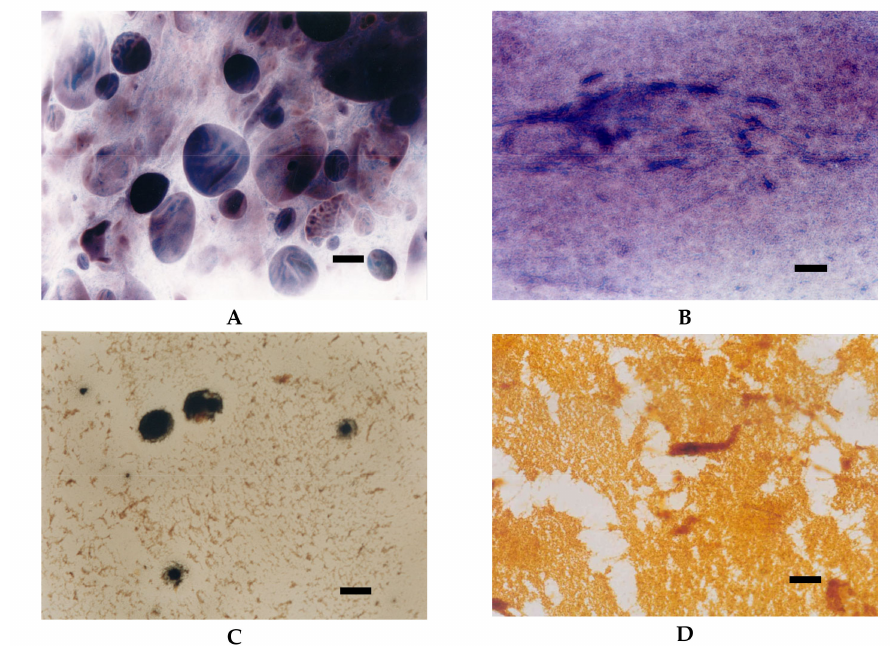
Figure 12. LM micrographs (20 × ) of potato cationic starches with di ff erent degrees of substitution incubated at di ff erent temperatures: ( A ) DS = 0.04, 60 ◦ C; ( B ) DS = 0.04, 90 ◦ C; ( C ) DS = 0.13, 25 ◦ C; ( D ) DS = 0.27, 25 ◦ C (Bar-20 µ